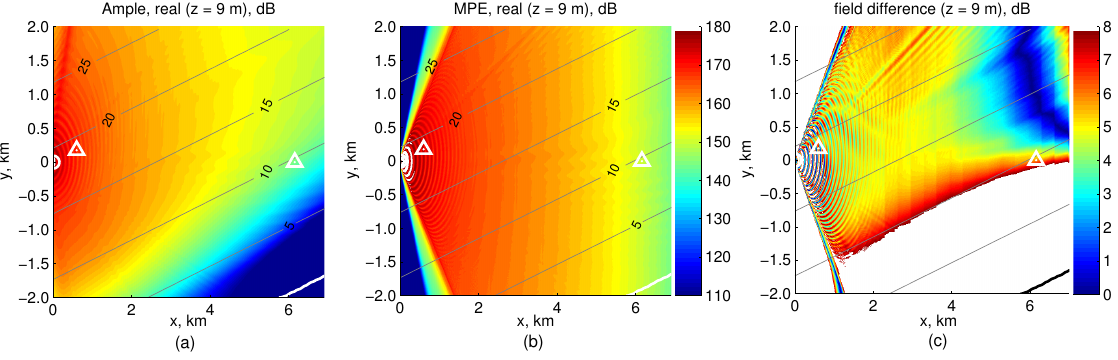
Figure 4. Spatial distribution of the SEL parameter at a horizon of 9 m, calculated by Ample ( a ) and MPE ( b ) for the waveguide model with the bottom slope given by Equation (9). SEL difference modulus is also shown ( c